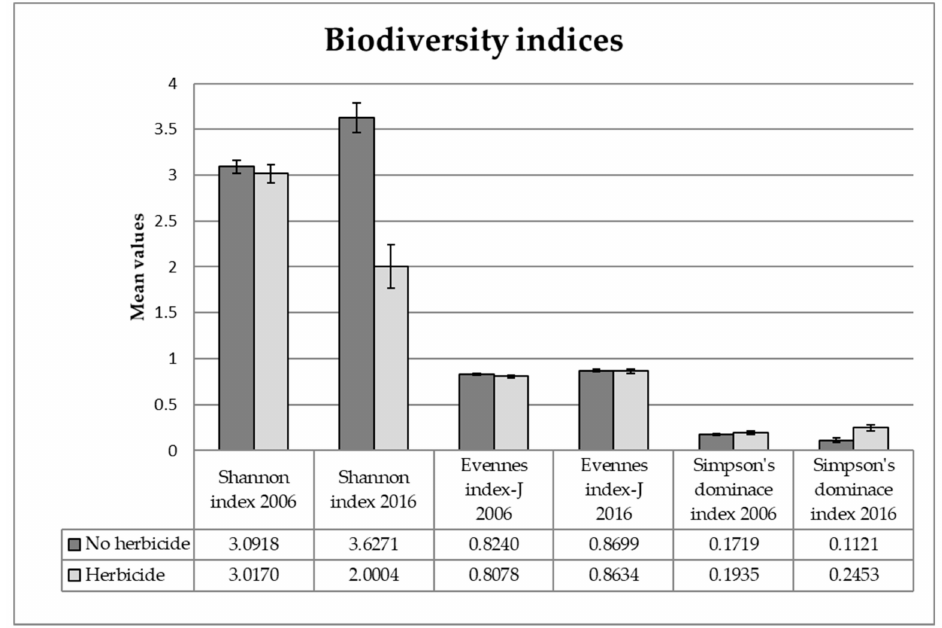
Figure 3. Comparative biodiversity indices between the 2006 and 2016 surveys under the two types of grass cover management. The error bars show the standard